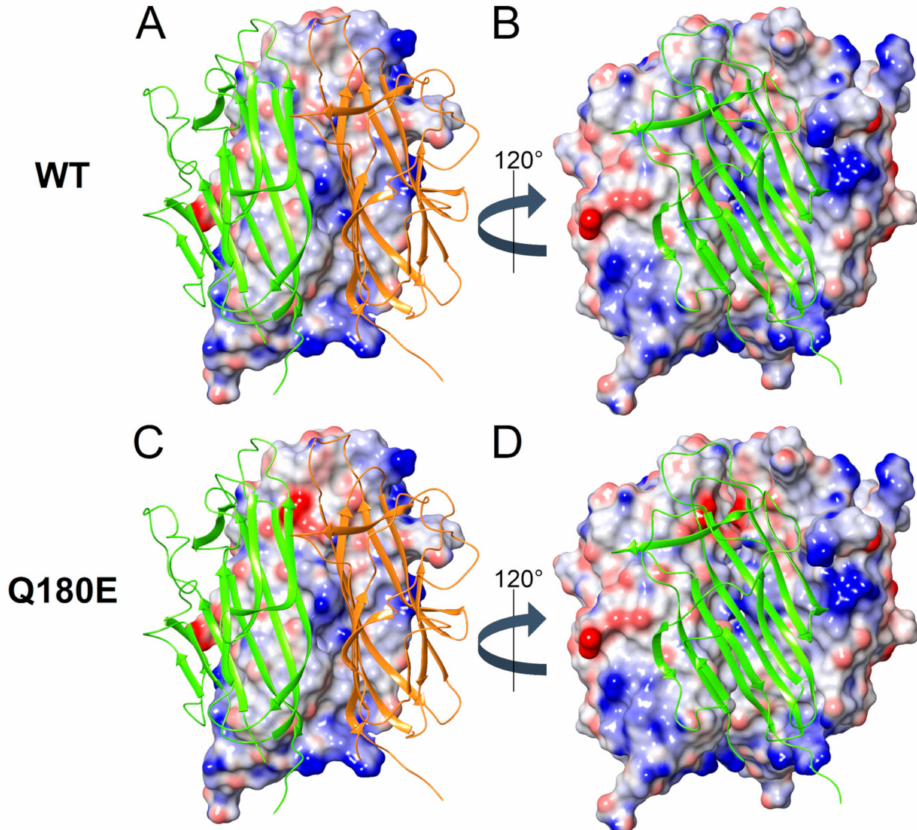
Figure 9. Electrostatic potential mapped on the molecular surface of a C1QTNF5 wild-type (WT) ( A , B ) and Q180E ( C , D ) homozygous trimer. Protein structure is shown in cartoon, protomer B is colored in orange, protomer C in green. The molecular surface of protomers A and B is colored in a blue-to-red scale from − 0.3 to 0.3 kT/e. ( A , C ) Electrostatic potential of protomer A. ( B , C ) Electrostatic potential of protomers A and B, protein view is rotated by 120 ◦ counterclockwise along the symmetry